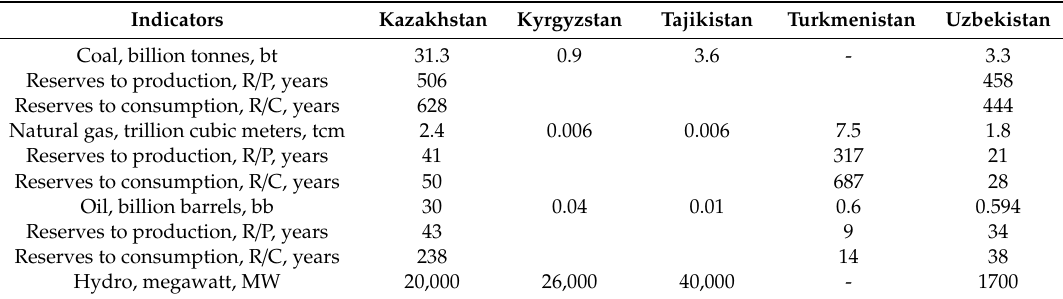
Table 7. Asian Countries’ Energy Resource Endowment (Source: author).